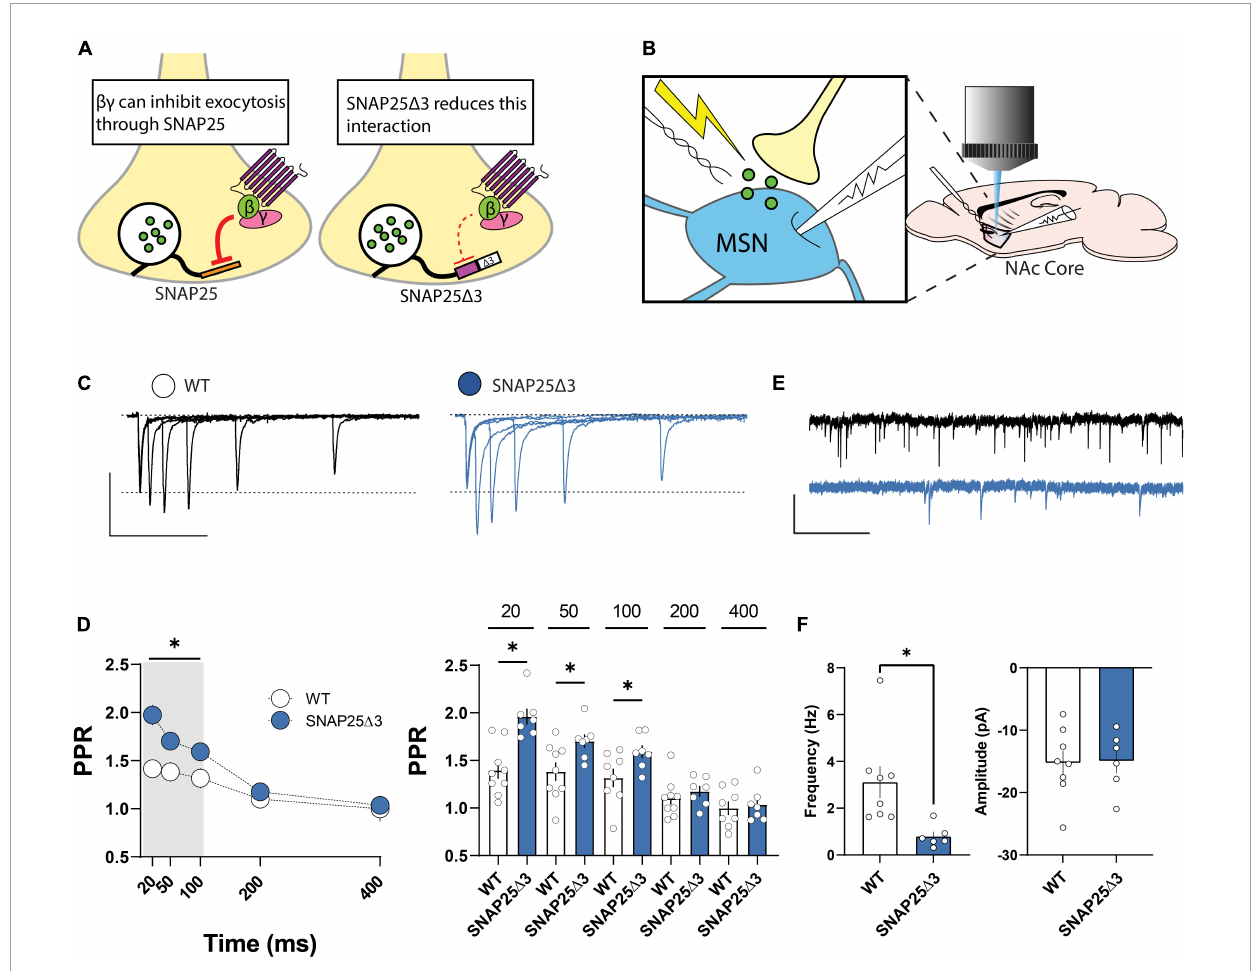
FIGURE1 The SNAP25 (cid:49) 3 mutation results in changes of basal excitatory transmission in the nucleus accumbens. (A) SNAP25 (cid:49) 3 reduces the interaction between SNARE-complex protein SNAP25 and the G βγ subunits of G i / o -coupled GPCRs. (B) Experimental setup depicting whole-cell voltage clamp of an MSN in the nucleus accumbens core and electrical stimulation of synaptic terminals to provoke release of presynaptic glutamate. (C) Representative traces of EPSCs elicited by stimulation of synaptic terminals at varying interstimulus intervals in WT (black) and SNAP25 (cid:49) 3 (blue) mice (scale bar: vertical = 100 pA, horizontal = 200 ms). (D) Differences in paired-pulse ratios (PPR) shown at 20 ms (WT: mean = 1.396 ± 0.09, SNAP25 (cid:49) 3: mean = 1.96 ± 0.8; p = 0.0005), 50 ms (WT: mean = 1.382 ± 0.10; SNAP25 (cid:49) 3: mean = 1.70 ± 0.07; p = 0.0254), and 100 ms (WT: mean = 1.32 ± 0.10; SNAP25 (cid:49) 3: mean = 1.59 ± 0.068; p = 0.0434), but not 200 ms or 400 ms delays. [WT: n = 9 cells; SNAP25 (cid:49) 3: n = 7 cells]. (E) Representative traces of spontaneous EPSCs recorded from MSNs from WT (black) and SNAP25 (cid:49) 3 (blue) mice (scale bar: vertical = 20 pA, horizontal = 1 s). (F) Decrease in the frequency of sEPSCs (WT: mean = 3.12 Hz ± 0.69; SNAP25 (cid:49) 3: mean = 0.80 ± 0.19; p = 0.0017) but not amplitude (WT: mean = − 15.26 ± 1.98 pA; SNAP25 (cid:49) 3: mean = − 14.94 ± 1.95 pA; p = 0.9114) in SNAP25 (cid:49) 3 mice. [WT: n = 8 cells, SNAP25 (cid:49) 3: n = 6 cells]. Error bars indicate SEM. ∗ p < 0.05. Student’s unpaired, two-tailed, t